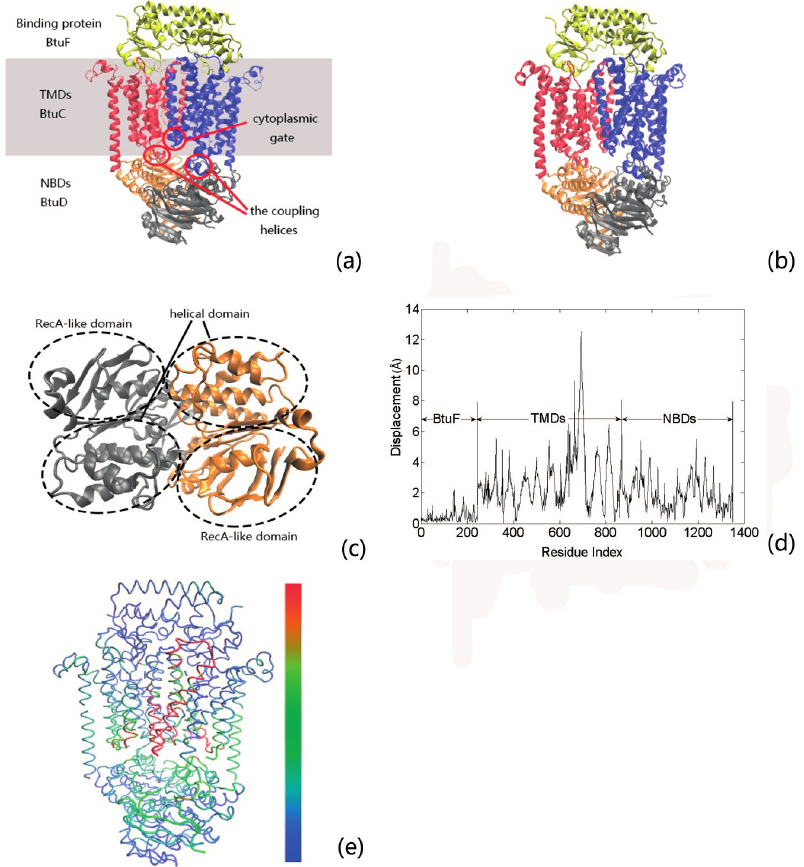
Figure 1. The tertiary structure of BtuCD–BtuF complex at the nucleotide-bound intermediate state (protein data bank (PDB) code: 4FI3) ( a ) and the apo complex state (PDB code: 4DBL) ( b ). BtuCD consists of two transmembrane domains (TMDs, i.e. , BtuC subunits) and two cytoplasmic nucleotide-binding domains (NBDs, i.e. , BtuD subunits). BtuF binds to the periplasmic side of BtuCD. The TMDs of BtuCD form the substrate translocation channel, whose cytoplasmic gate is marked by red circle in panel ( a ). In this study, the extent of opening of the cytoplasmic gate is chosen as the internal coordinate that related to the channel-gating function of the protein. The coupling helices that connect TMDs and NBDs are also marked by red circles in the figure; The top view of NBDs is displayed in panel ( c ), in which the helical and RecA-like domains are highlighted by dotted circles; The residue displacements between the two states of BtuCD–BtuF are displayed ( d ); In order to intuitively display the calculation results, the residue displacements are also mapped onto the protein structure ( e ), where the yellow-red color indicates larger residue displacements and the blue color denotes lower